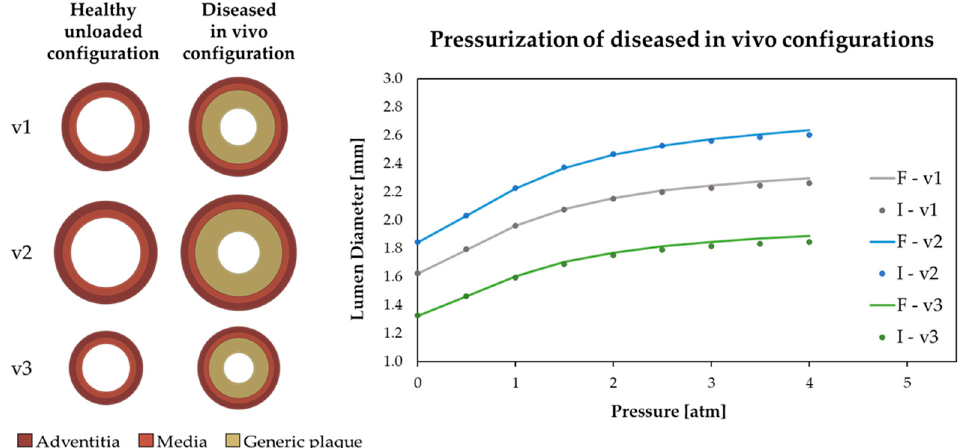
Figure 4. Validation of the strategy for modeling the media and adventitia layers with isotropic material calibrated on the circumferential in vivo behavior. On the left are the three different sizes of the healthy unloaded configuration of the idealized artery considered in the study: lumen diameters of the healthy unloaded artery of 2.7 mm (v1) (the one used for material calibration without the plaque), 3.2 mm (v2) and 2.2 mm (v3) were chosen. Starting from these geometries, three different configurations of diseased in vivo vessels were derived considering the deformations of media and adventitia under in vivo conditions and the addition of a generic plaque such as to model a 50% stenosis of the healthy lumen. Simulations of lumen pressurization of the three diseased in vivo configurations were performed for a comparison between the isotropic model calibrated on the in vivo circumferential behavior (I) and the fiber-reinforced model accounting for stresses and strains starting from the unloaded configuration (F). On the right are the simulation results in terms of lumen diameter versus the applied pressure increment beyond the physiological pressure value of 100 mmHg.